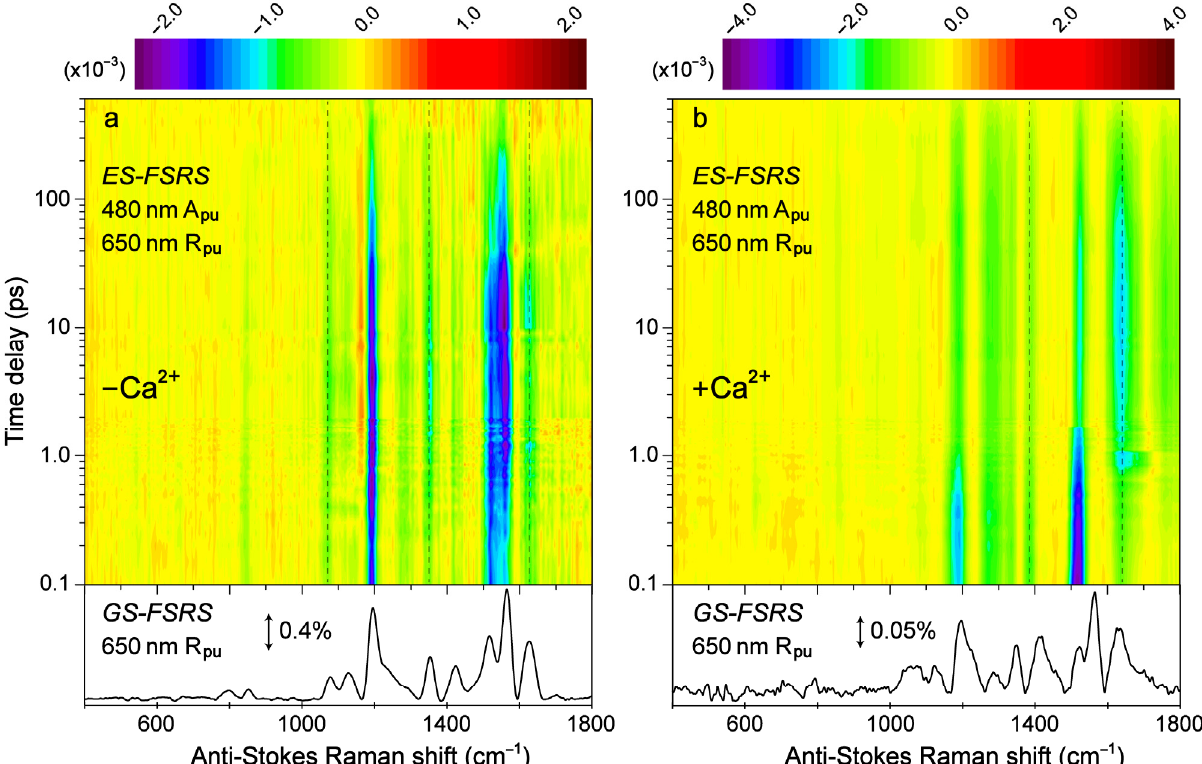
Figure 6. Contour plots of the excited-state (ES)-FSRS spectra of the ( a ) Ca 2+ -free and ( b ) Ca 2+ -bound REX-GECO1 biosensor in pH 7 aqueous buffer solutions. The FSRS data were collected with a 480 nm actinic pump (A pu ), 650 nm Raman pump (R pu ), and a bluer Raman probe on the anti-Stokes side. The color-coded stimulated Raman intensities (×10 –3 ) are indicated by the color bar above each contour plot. The ground-state (GS)-FSRS spectra (without 480 nm A pu ) are shown below each contour plot, with the denoted stimulated Raman intensity magnitude of 0.4 and 0.05% for the Ca 2+ -free and -bound biosensors, respectively (due to different resonance conditions achieved experimentally). The stimulated Raman shift axis is both multiplied by − 1 for the GS- and ES-FSRS spectra. The vertical dashed lines highlight several key transient vibrational peaks analyzed below.